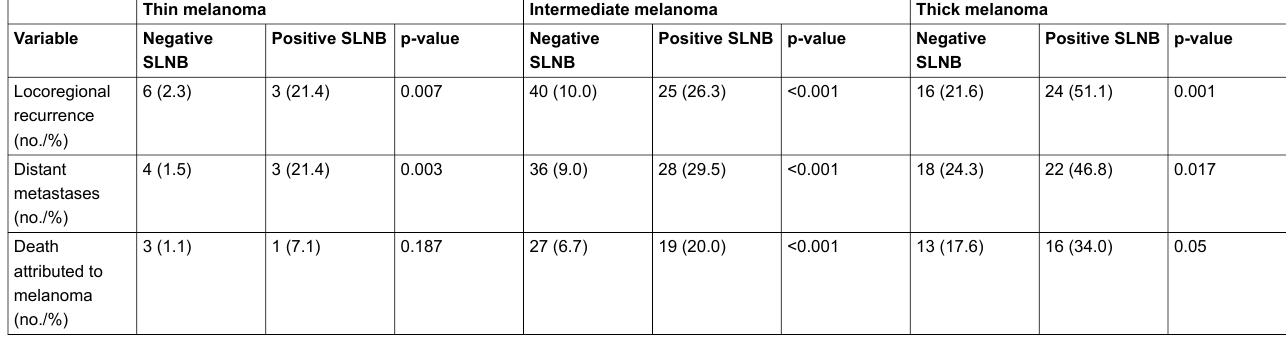
Table 3: The association between sentinel lymph node biopsy result and clinical outcomes in patients with melanomas of different thickness. Thin melanoma